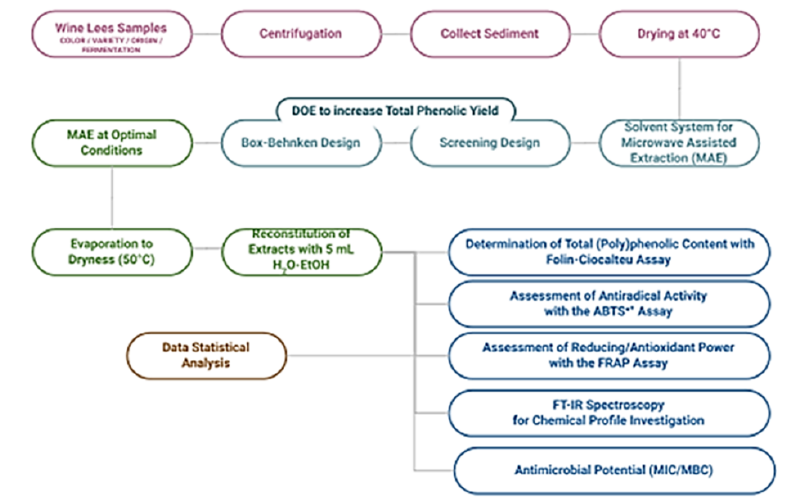
Figure 3. Flowchart of experimental process.